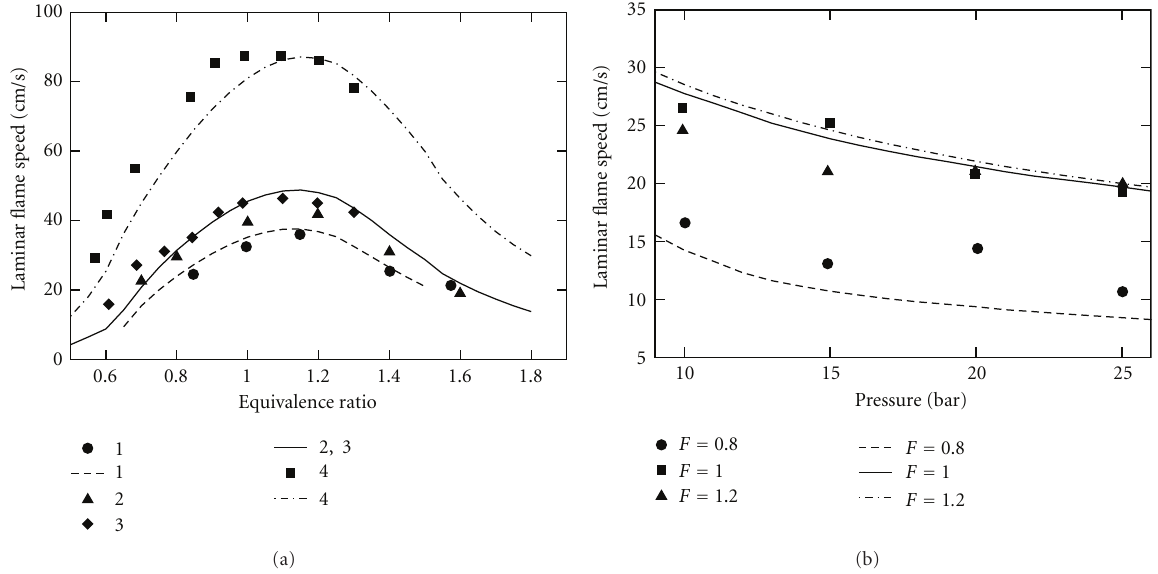
Figure 3: Validation of the chemical mechanism. Symbols show experimental data, and curves have been computed. (a) Laminar flame speed versus equivalence ratio. (1) T u = 298K, data by Metghalchi and Keck [29]. (2) T u = 350K, data by Metghalchi and Keck [29]. (3) T u = 353K, data by Zhao et al. [30]. (4) T u = 500K, data by Zhao et al. [30]. (b) Laminar flame speeds versus pressure at three di ff erent equivalence ratios specified in legends. T u = 373K. Data by Jerzembeck et al. [31].